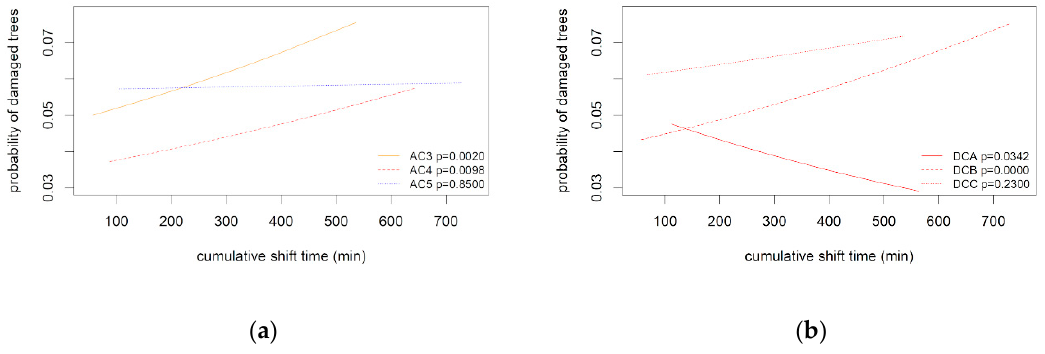
Figure 4. Tree damage probability as a function of the cumulative shift time with respect to: ( a ) age class, and ( b ) density class.